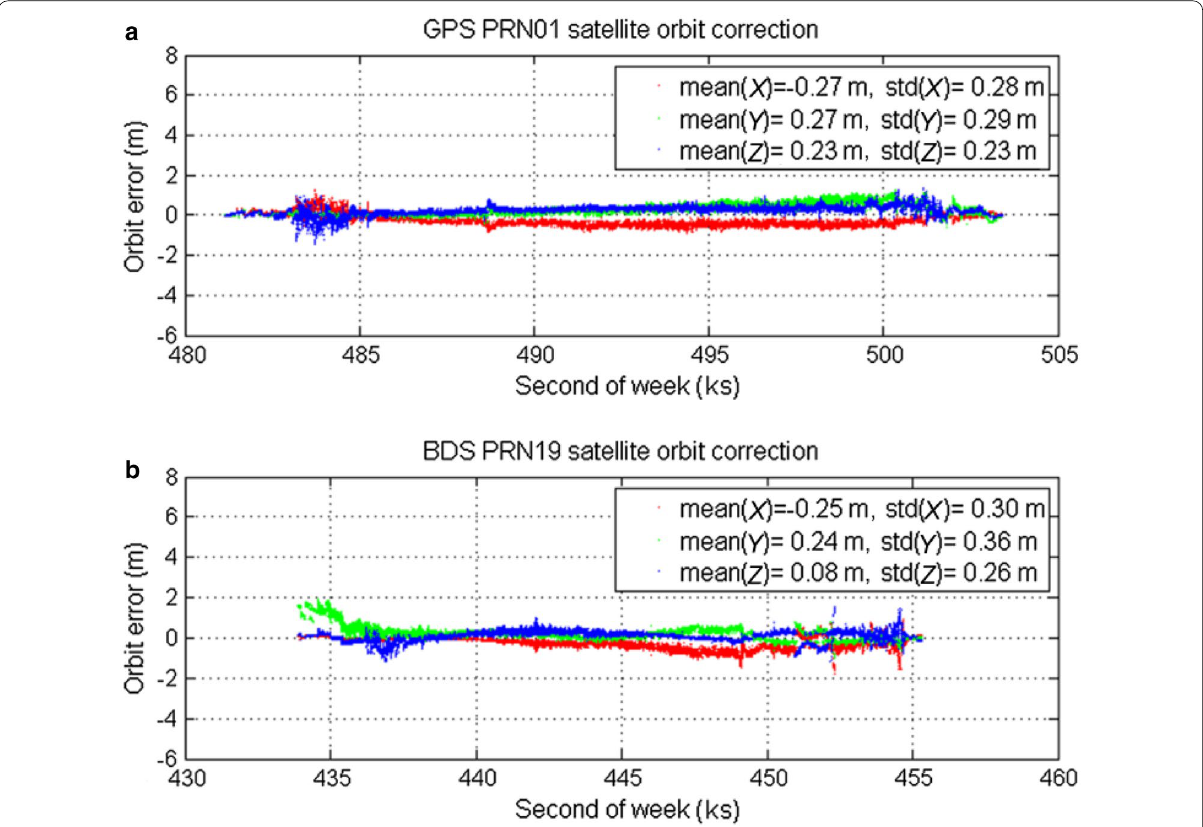
Fig. 3 Long-term orbit corrections of GPS PRN01 and BDS